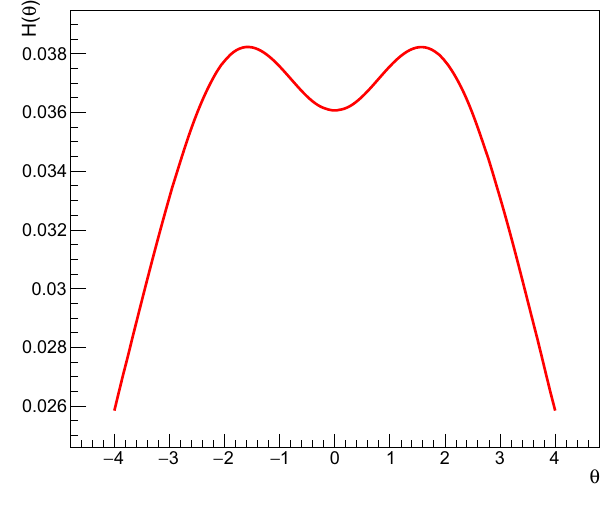
Fig. 2 Profile of the function H (η) chosen above we find that ω c ≈ 62 . 5 GeV and r ≈